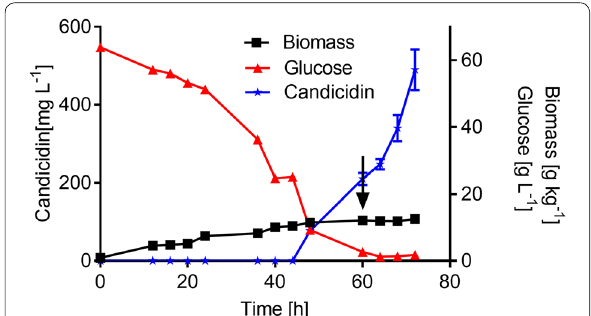
Fig. 2 Growth profiles of Streptomyces ZYJ-6 in a chemically defined medium. The arrow represents sampling time at 60 h in a stable growth state, ensuring that the cell physiology was relatively reproducible. Error bars indicate standard deviations of the three independent samples, some of which are hidden under symbols. Diamonds, biomass [g kg − 1 ]; triangles, glucose [g L − 1 ]; pentagrams, candicidin [mg L − 1